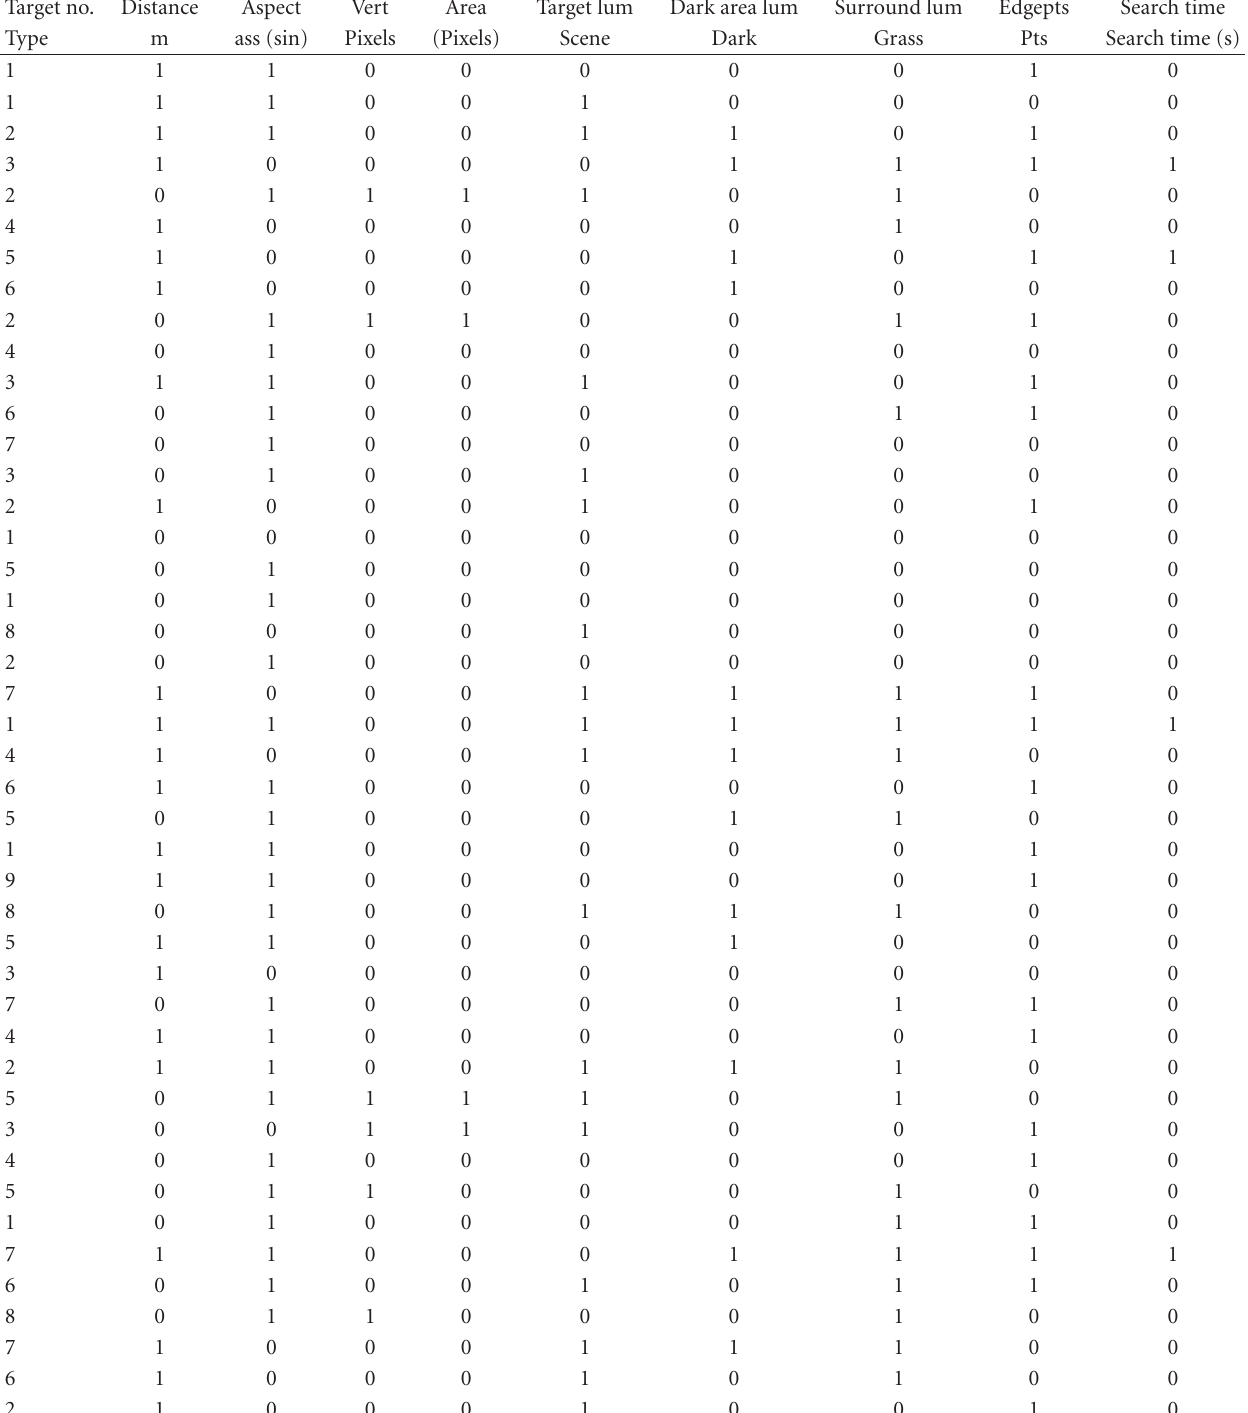
Table 4: This Boolean data is presented in Table